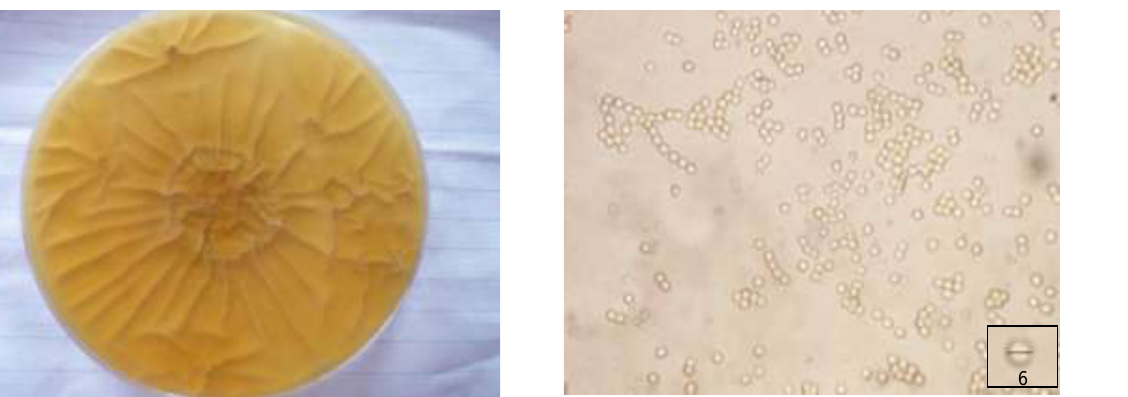
Figure 4: Branchiomyces spp. culture after 7 days of cultivation, the colonies shows as folded heaped, glabrous and velvety, white in color and with white –yellowish in reveries site.